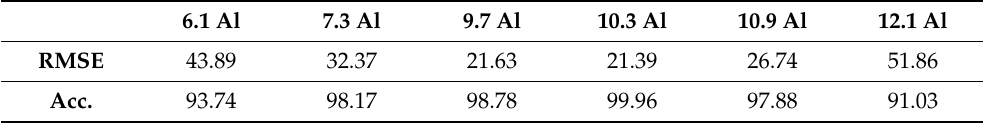
Table 7. Table showing the RMSE and accuracy (Acc.) calculated for the proposed hybrid model at different, randomly selected chemical compositions (see Figure 6). The general accuracy of our proposal is 96.59